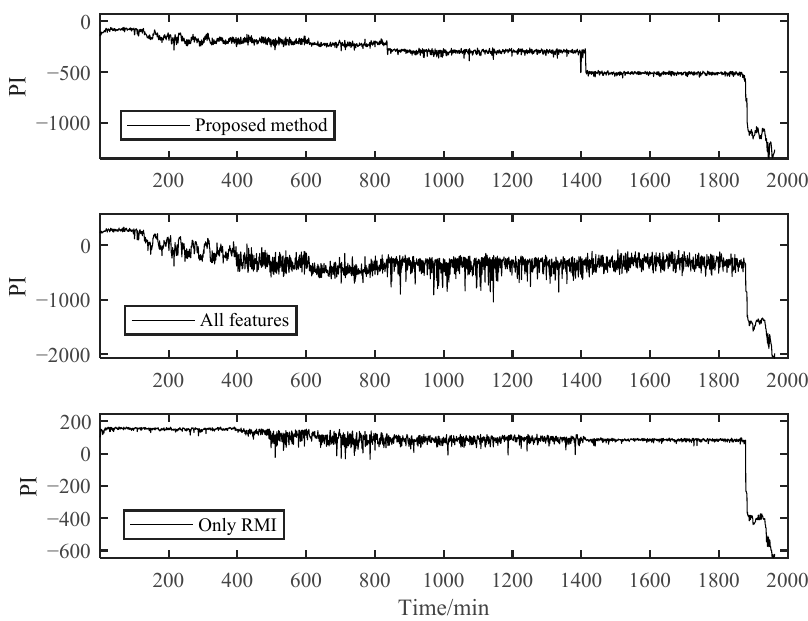
Figure 18. Comparison of three different methods of B2.